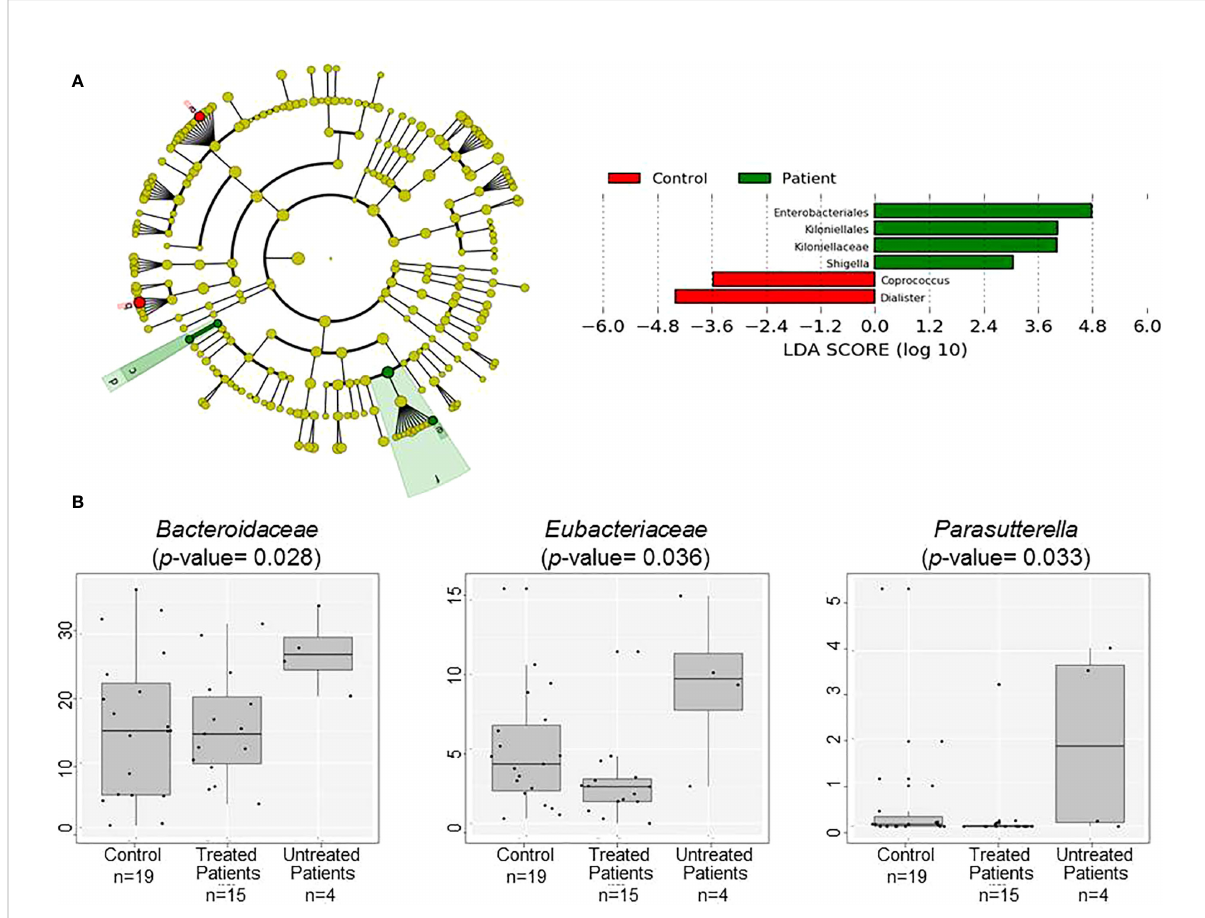
FIGURE 2 Comparison of patients ’ and controls ’ microbiota. (A) Cladogram plotted of the studied population ’ microbiota. Cladograms show the different taxonomic levels by rings; the root of the cladogram denotes the domain bacteria, phyla were represented in the inner ring and genus in the outer one. The plotted represents the microbial differences in patients (green), and controls (red). On the right Linear discriminant analysis (LDA) analysis shows differentially abundant bacterial groups as biomarkers determined using Kruskal-Wallis test (P<0.05) with LDA score >2.0. a: Coprococcus, b: Dialister, c: Kiloniellaceae, d: Kiloniellales, e: Shigella, f: Enterobacteriales (B) Box plot showing the abundance of the main bacterial groups that differ in fecal samples of the patients grouped according to the used or not of disease modifying treatment and